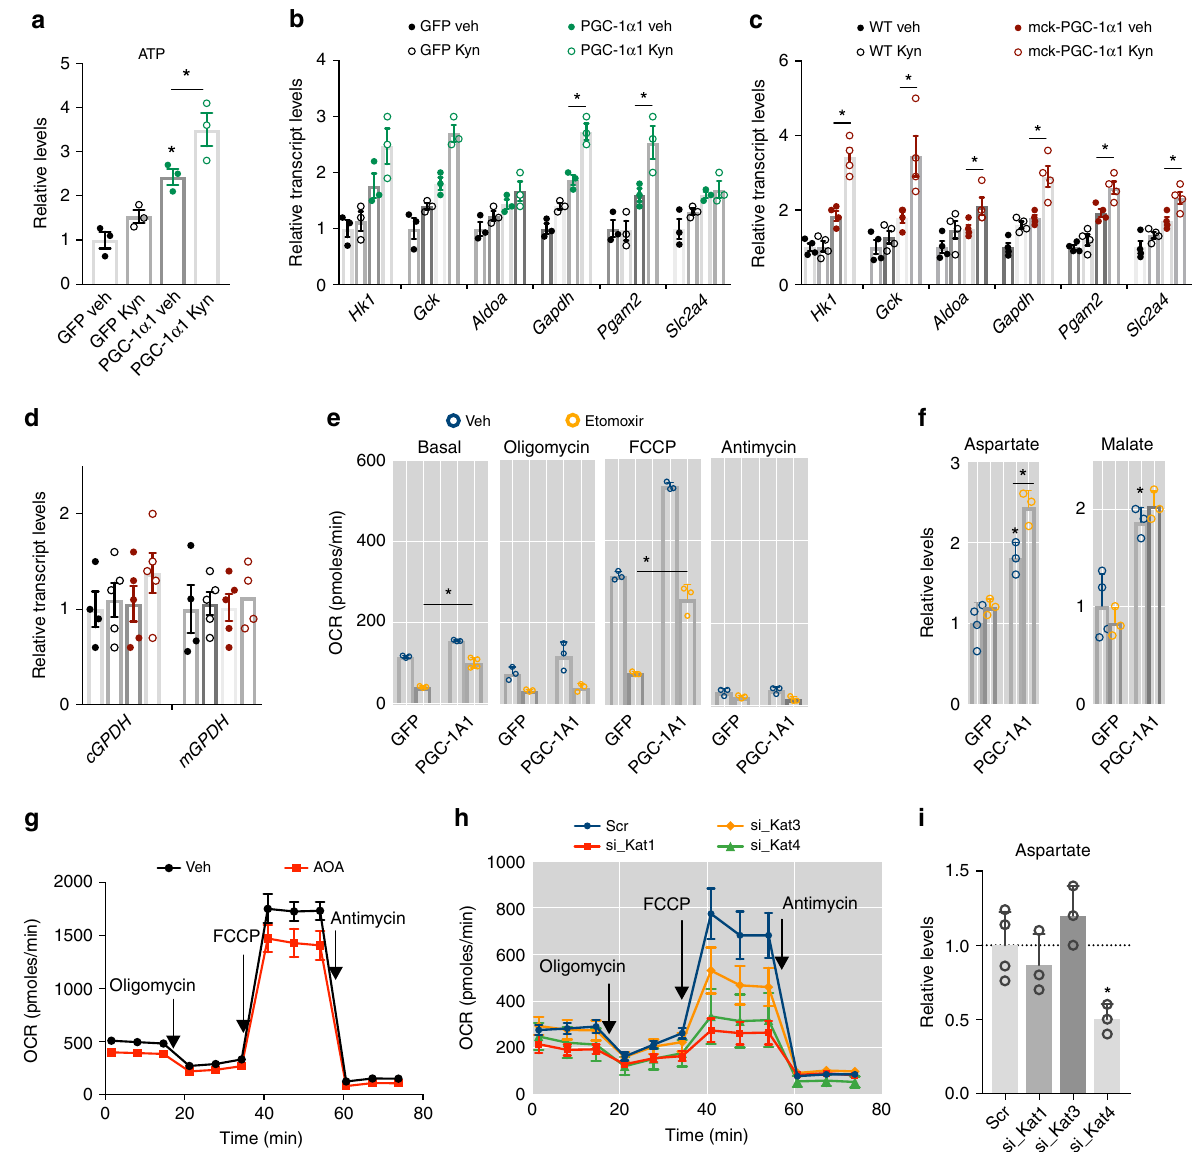
Fig. 3 The bioenergetic role of Kat/malate-aspartate shuttle integration in skeletal muscle. a Relative levels of ATP in primary myotubes transduced with Gfp control or Pgc-1 α 1 adenovirus supplemented with 1 μ M kynurenine (Kyn) ( n = 4). b Relative transcript levels of glycolytic genes in primary myotubes transduced with Gfp control or Pgc-1 α 1 adenovirus and supplemented with 1 μ M Kyn ( n = 4). c Relative transcript levels of glycolytic genes in skeletal muscle of wt and mck-PGC-1 α 1 mice with a single intraperitoneal dose of Kyn (2.5 mg/kg) ( n = 4). d Relative transcript levels of glycerol-3-phosphate shuttle genes in skeletal muscle of wt and mck-PGC-1 α 1 mice treated as in c . e Cellular respiration measured by Extracellular Flux Analysis (Seahorse TM ) in primary myotubes transduced with Gfp control or Pgc-1 α 1 adenovirus and supplemented with 50 μ M Etomoxir for 1 h ( n = 4). f Relative levels of aspartate and malate in primary myotubes transduced with Gfp control or Pgc-1 α 1 adenovirus and supplemented with 50 μ M Etomoxir for 1 h ( n = 4). g Cellular respiration measured as in e of primary myotubes supplemented with 100 μ M aminooxyacetate (AOA) for 1 h ( n = 4). h Cellular respiration measured as in e of primary myotubes transfected with scrambled siRNA, or siRNAs for Kat1 , Kat3 or Got2/Kat4 ( n = 4). i Relative levels of aspartate in primary myotubes transfected as in h . Bars depict mean values and error bars indicate SEM. Unpaired, two-tailed student ’ s t -test was used when two groups were compared, and one-way analysis of variance (ANOVA) followed by Fisher ’ s least signi fi cance difference (LSD) test for post hoc comparisons were used to compare multiple groups, * p <